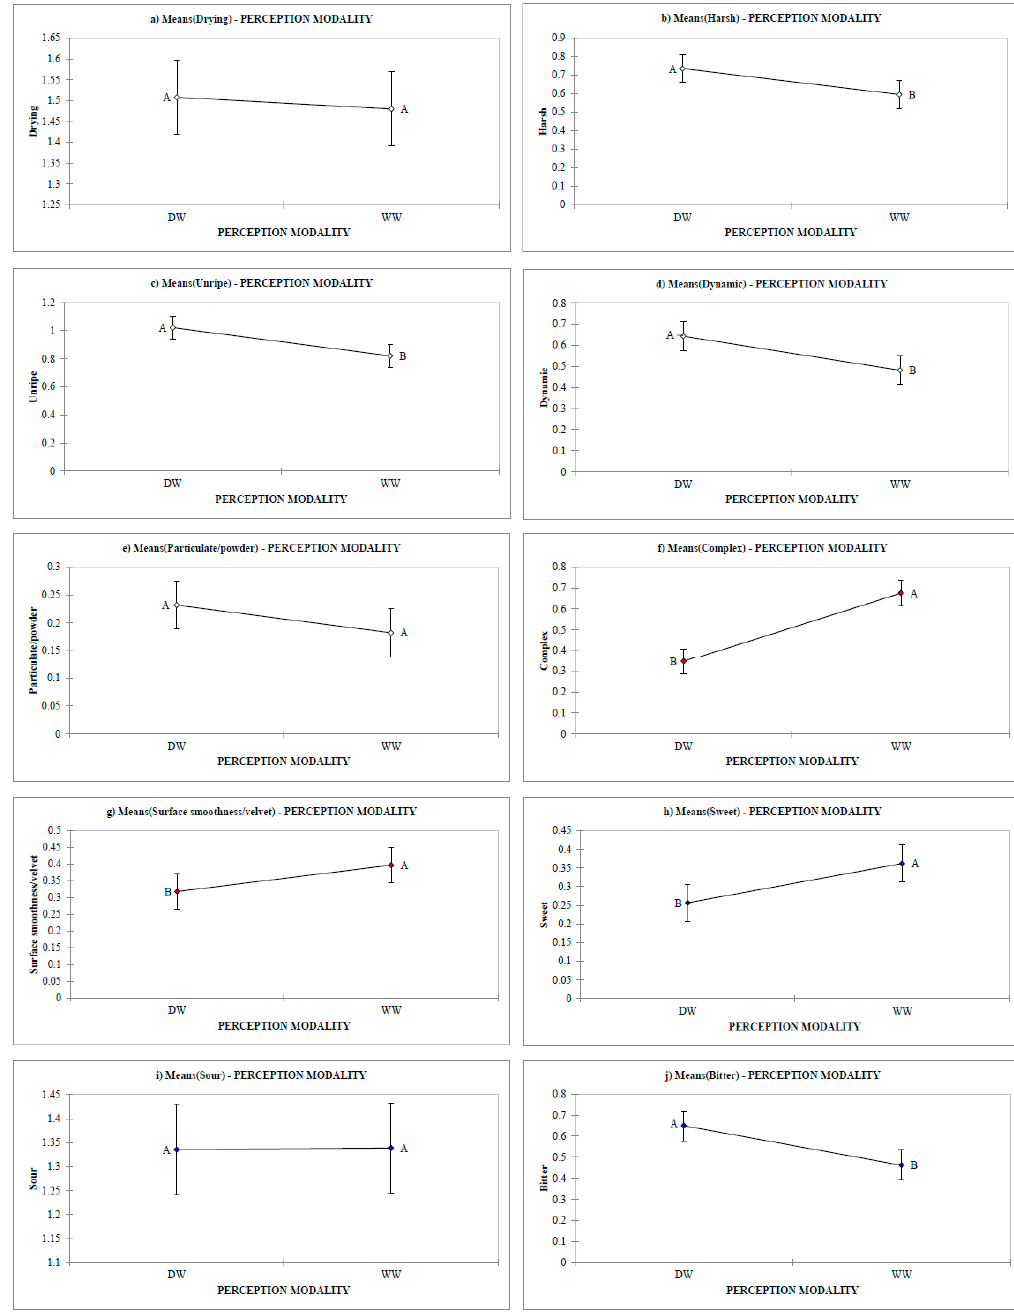
Figure 3. Variation of mean intensities (over 74 wines) of each astringency sub-quality and taste sensation during DWs tasting compared to corresponding WW: ( a ) Drying, ( b ) Harsh, ( c ) Unripe, ( d ) Dynamic, ( e ) Particulate / powder, ( f ) Complex, ( g ) Surface smoothness / Velvet, ( h ) Sweet, ( i ) Sour and ( j ) Bitter. Significant di ff erences are marked with di ff erent letters ( p < 0.05). whole wines (WWs), deodorized wines (DWs).